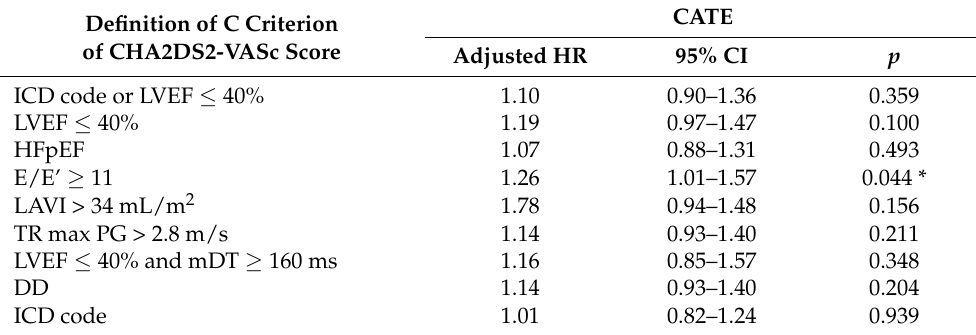
Table 3. Multivariable-adjusted Cox regression analysis of each CHA 2 DS 2 -VASc scores using different definitions for congestive heart failure in predicting composite thromboembolic events.